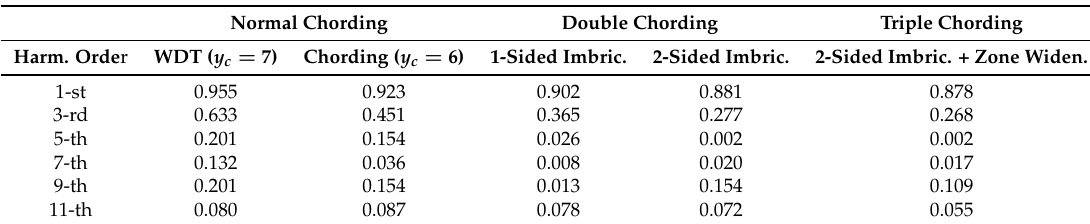
Table 20. Winding factor harmonics with different optimization techniques for N = 72, p = 5, m = 3 and q = 2 + 2 / 5